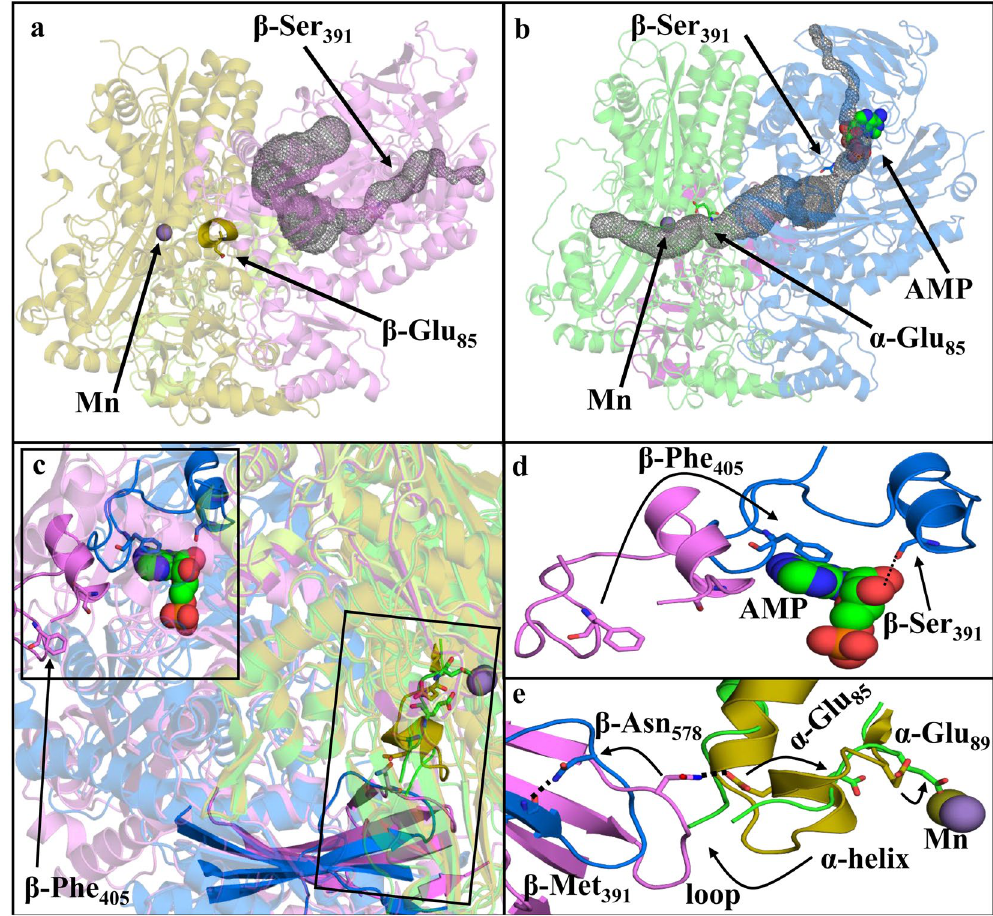
Figure 2. Conformational shift upon nucleotide binding. ( a ) Ligand-free structure ( α subunits: olive; β subunits: violet; γ subunits: limon) showing a substrate channel (grey) linking the nucleotide binding site to solvent and allowing ATP and substrates to enter. Access to the Mn site is closed off in this structure by an Mn proximal α -helix that prevents the substrate channel from reaching the Mn active site. ( b ) AMP-bound structure ( α subunits: green, β subunits: blue, γ subunits: pink) showing an opening of an internal channel (grey) linking the nucleotide binding site to the Mn binding site. The Mn proximal helix becomes a disordered loop region when AMP is bound, permitting access to the Mn. ( c ) Superposition of the ligand-free structure on the AMP-bound structure. The structures as a whole are rendered semi-transparently. Boxes highlight regions with important changes, and key features are rendered in fully-opaque colors. ( d ) Close up of the upper boxed region in ( c ) illustrating pronounced changes in the positions of β -Phe405 and β -Ser391 upon binding of nucleotide. ( e ) Detailed representation of the lower boxed region in ( c ). A cross-subunit β -Asn578/ α -Glu85 interaction in the ligand-free structure is disrupted following AMP binding. This allows α -Glu85 to move in the direction of the arrow and leads to destabilization of the Mn-proximal α -helix shown in ( a ). These changes together allow the α -Glu89 side chain to rotate to coordinate to the